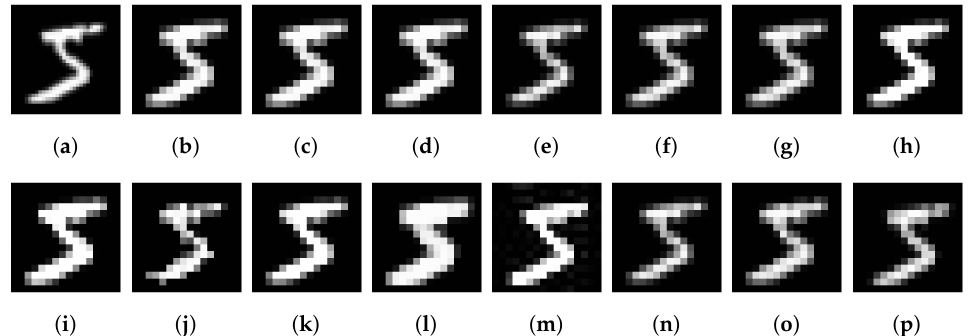
Figure 7. The MNIST “5” original image ( a ) and the respective results of the first pass of pooling for the methods Max ( b ), adaptive Max ( c ), fractional ( d ), Average ( e ), mixed ( f ), gated ( g ), tree ( h ), l2 ( i ), stochastic ( j ), fuzzy ( k ), overlapping Max ( l ), spectral ( m ), wavelet ( n ), LIP ( o ), and SoftPool ( p ).